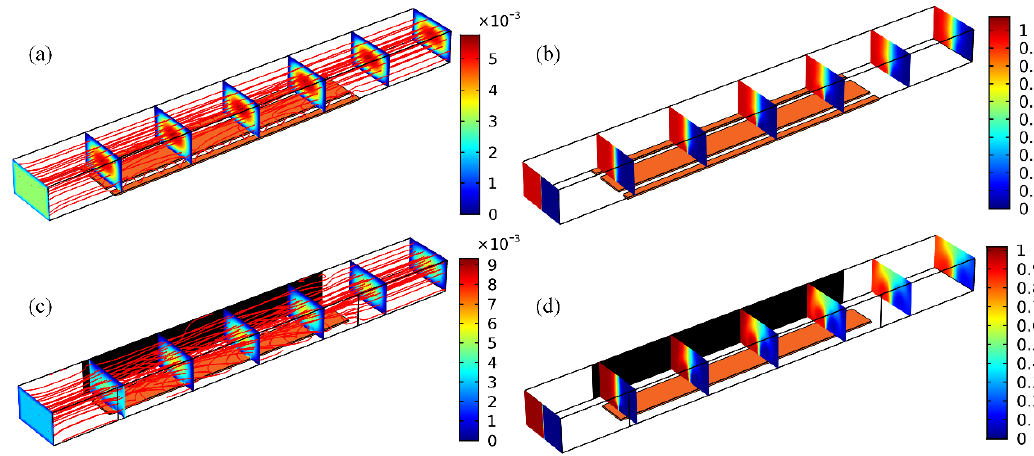
Figure 3. Simulation result of ICEO sample mixing in axial continuous flow of inlet flow rate u 0 = 3mm/s and solution conductivity 0.001 S/m in the fundamental configuration of single floating gate terminal under given frequency f = 200 Hz and field intensity E B = 20,000 V/m. ( a , b ) With 2D electrode layouts, symmetrically circulating ICEO vortex flow induced on the surface of gate strip intersects perpendicularly with the incoming sample stream, resulting in a mixing performance of γ = 26.48% by lateral electroconvection which extends the phase interface without any hydrodynamic torque, ( c ) a streamline and multi-slice surface plot of flow field (unit: m/s), ( d ) a multi-slice surface plot of analyte concentration distribution affected by symmetric electroosmotic whirlpools in the transverse plane (unit: mol/m 3 ). ( c , d ) Corresponding simulation results in 3D electrode configuration, with an enhanced device efficiency of γ = 50.1%, albeit still not ideal.